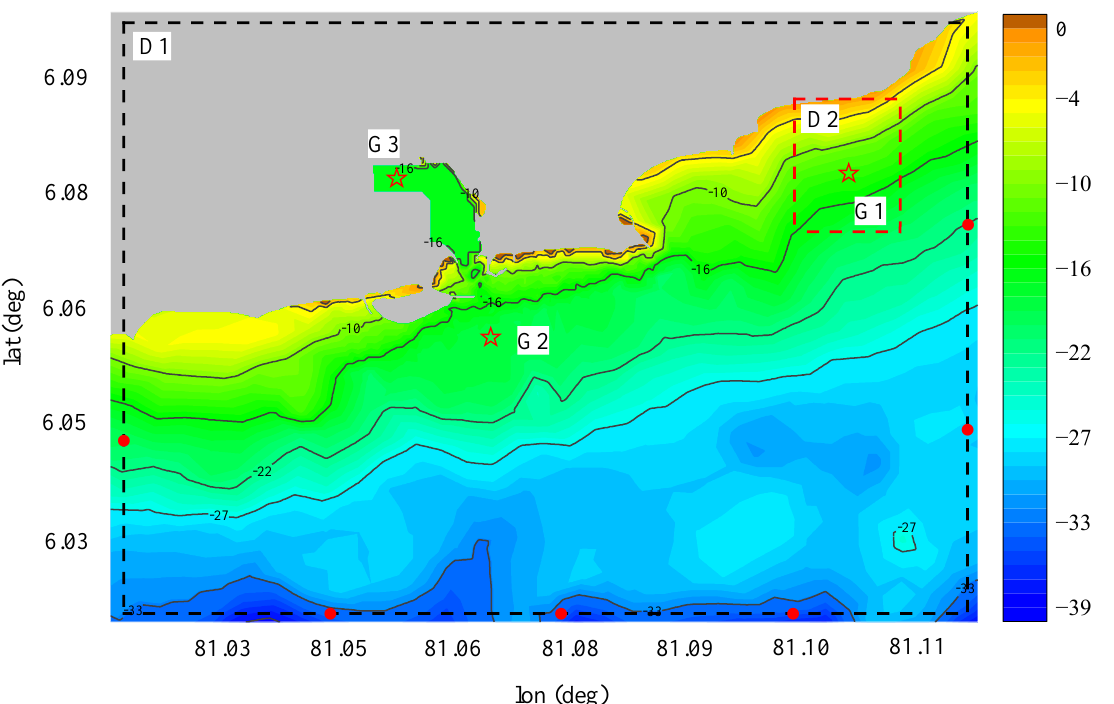
Figure 2. Computational domains used in the numerical simulation: D1 (within the black dotted line) and D2 (within the red dotted line). AWAC sensors are depicted as red stars, and the red dots represent the input positions of the wave spectra obtained from WW3.